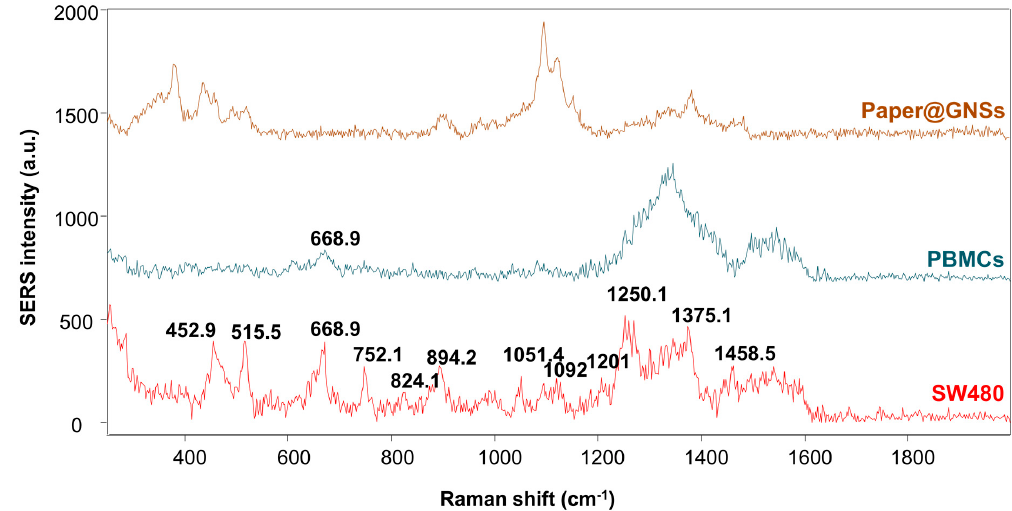
Figure 6. Spectrum of the paper (blank), and cell lysate from healthy (PBMCs) and cancer (SW480) cells, obtained by using the developed SERS paper substrate. Each spectrum showed is the average of five spectra taken at different positions of the substrate. Table 1. Assignment of the Raman vibrations corresponding to cell molecular components. Raman Shift (cm − 1